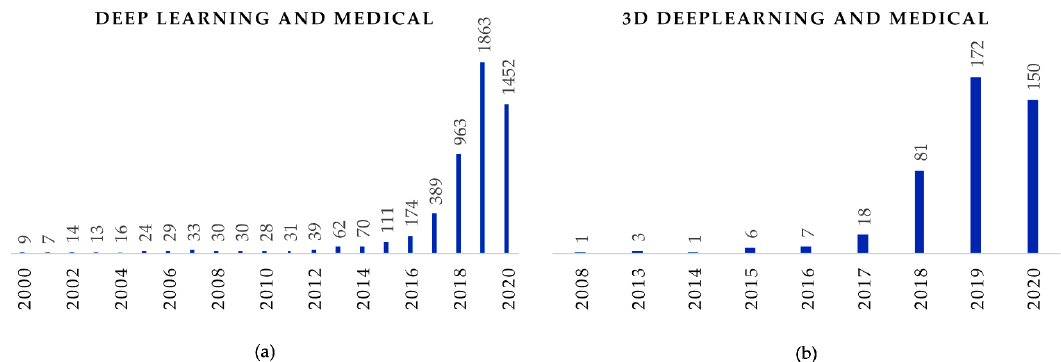
Figure 1. Year-wise number of publications in PubMed while searching for ‘deep learning + medical’ and ‘3D deep learning + medical’ in the title and abstract in PubMed publication database (as at 1st